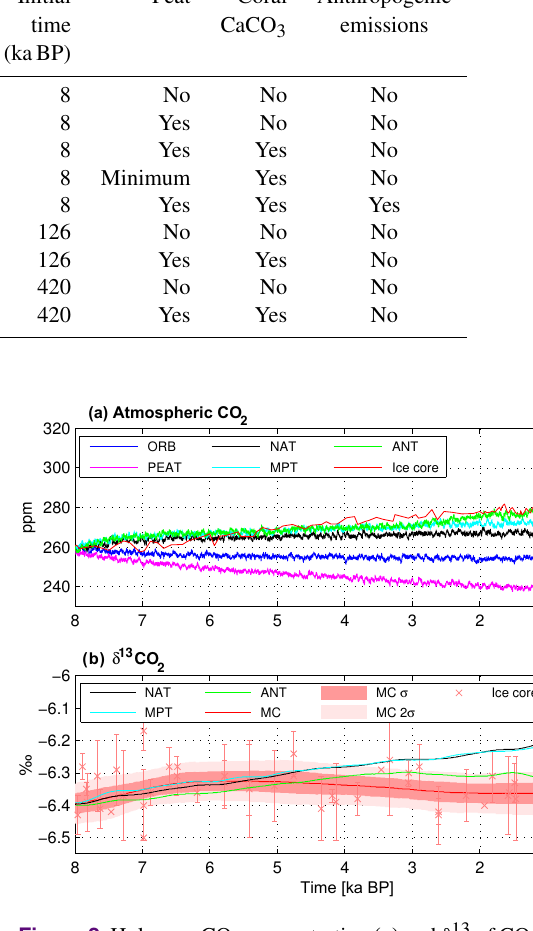
Figure 2. Holocene CO 2 concentration (a) and δ 13 of CO 2 (b) from model experiments and ice core data. δ 13 CO 2 model results have been smoothed for clarity and offset, as described in the text. Ice core CO 2 data are from Law Dome and EDC as compiled by Bere- iter et al. (2015). δ 13 CO 2 data are from EDC (Elsig et al., 2009), with Monte Carlo average (MC) and uncertainty estimate (MC σ ; Schmitt et al.,